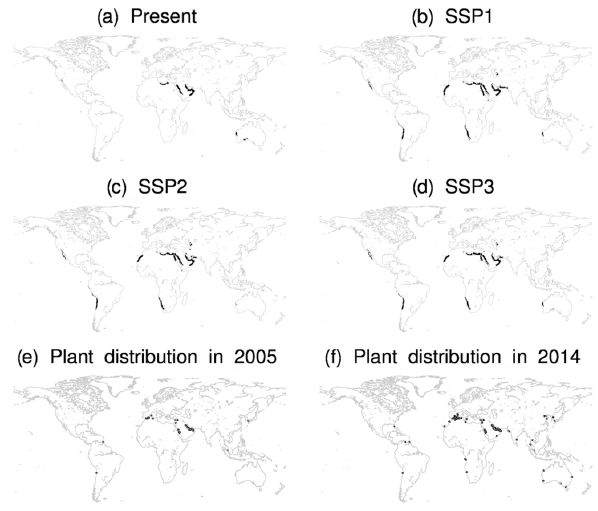
Figure 6. Global distributions of area utilizing seawater desalina- tion (AUSD) in (a) 2005, (b) SSP1 in 2055, (c) SSP2 in 2055, and (d) SSP3 in 2055. Locations of seawater desalination plants (larger than 50000m 3 day − 1 in capacity) in (e) 2005 and (f)